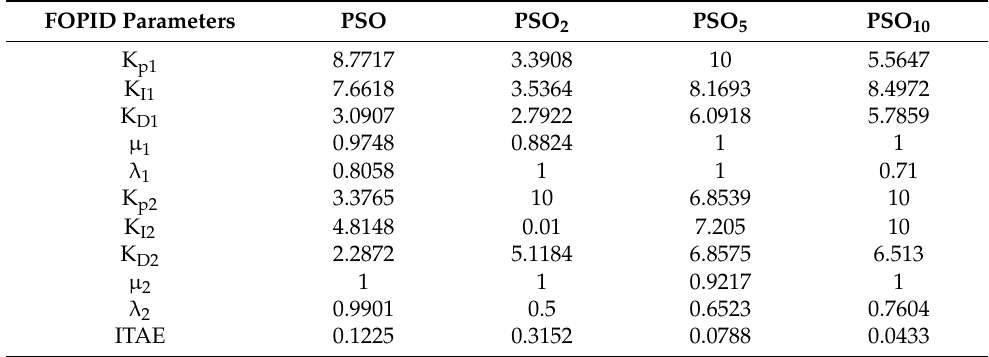
Table 5. Optimally tuned parameters of FOPID controllers with different optimisation techniques for case